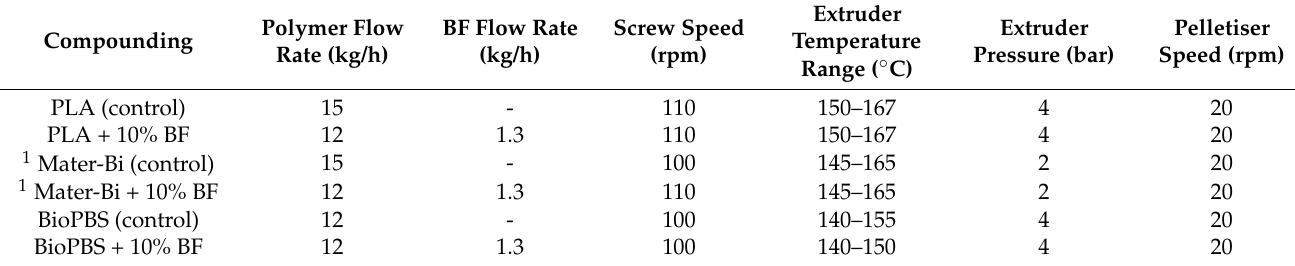
Table 10. The 2nd and 3rd film generation compounding extrusion